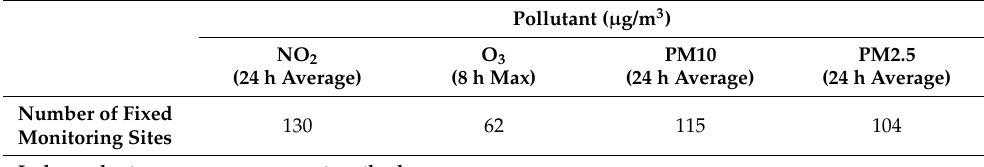
Table 3. Model performance evaluated by the value of adjusted R 2 and 10-fold cross validated (CV) R 2 , root mean square error (RMSE) and mean bias, for the independent and hybrid modeling approaches.